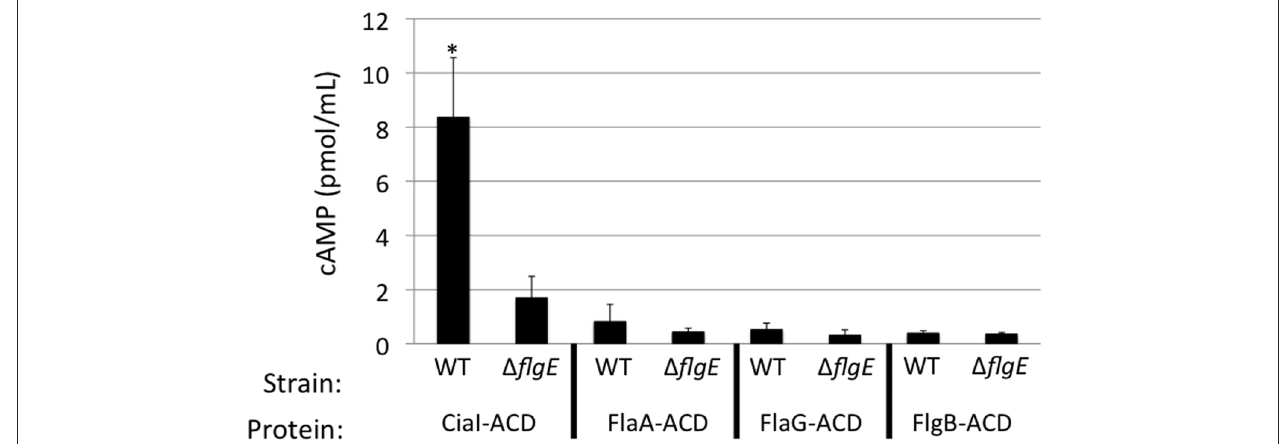
FIGURE 4 | CiaI is delivered from the C. jejuni F38011 wild-type strain to INT 407 cells. Delivery of the CiaI-ACD, FlaA-ACD, FlaG-ACD, and FlgB-ACD fusion proteins was assayed in the C. jejuni F38011 wild-type strain and isogenic flgE mutant. INT 407 cells were inoculated with the C. jejuni F38011 wild-type strain and flgE mutant harboring the various ACD plasmids. The